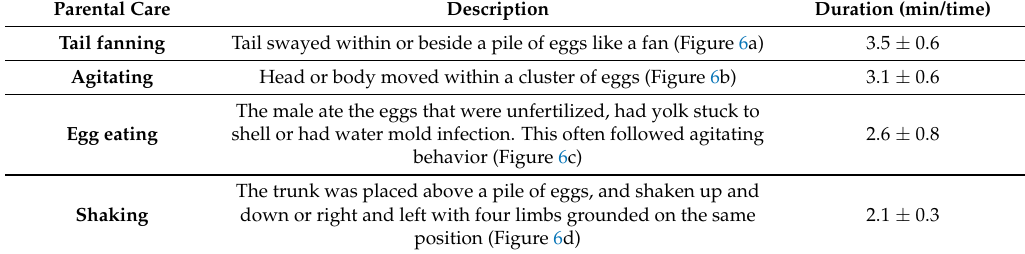
Table 4. Description of parental care in male A. davidianus .